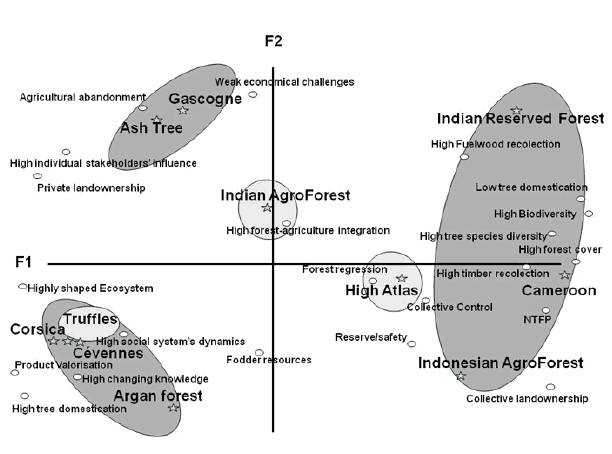
Fig. 1 . Representation of the 11 case studies of rural forests and some significant modalities of variables on the F1XF2 plan of the MCA. F1 and F2 are linear combinations provided by the MCA, which cover 22 and 19% of the total variance, respectively. Stars represent case studies; bullets represent main significant variables conforming these two